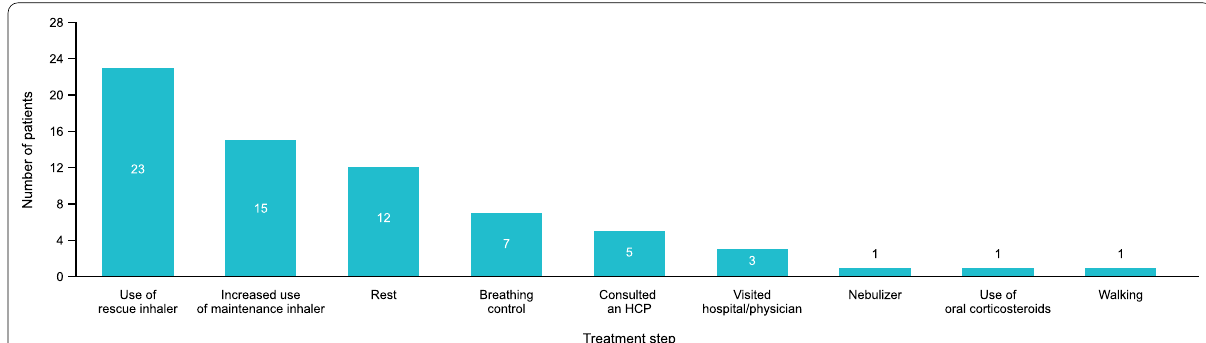
Fig. 3 Pharmacological and nonpharmacological management reported by patients for their moderate asthma exacerbations. HCP healthcare